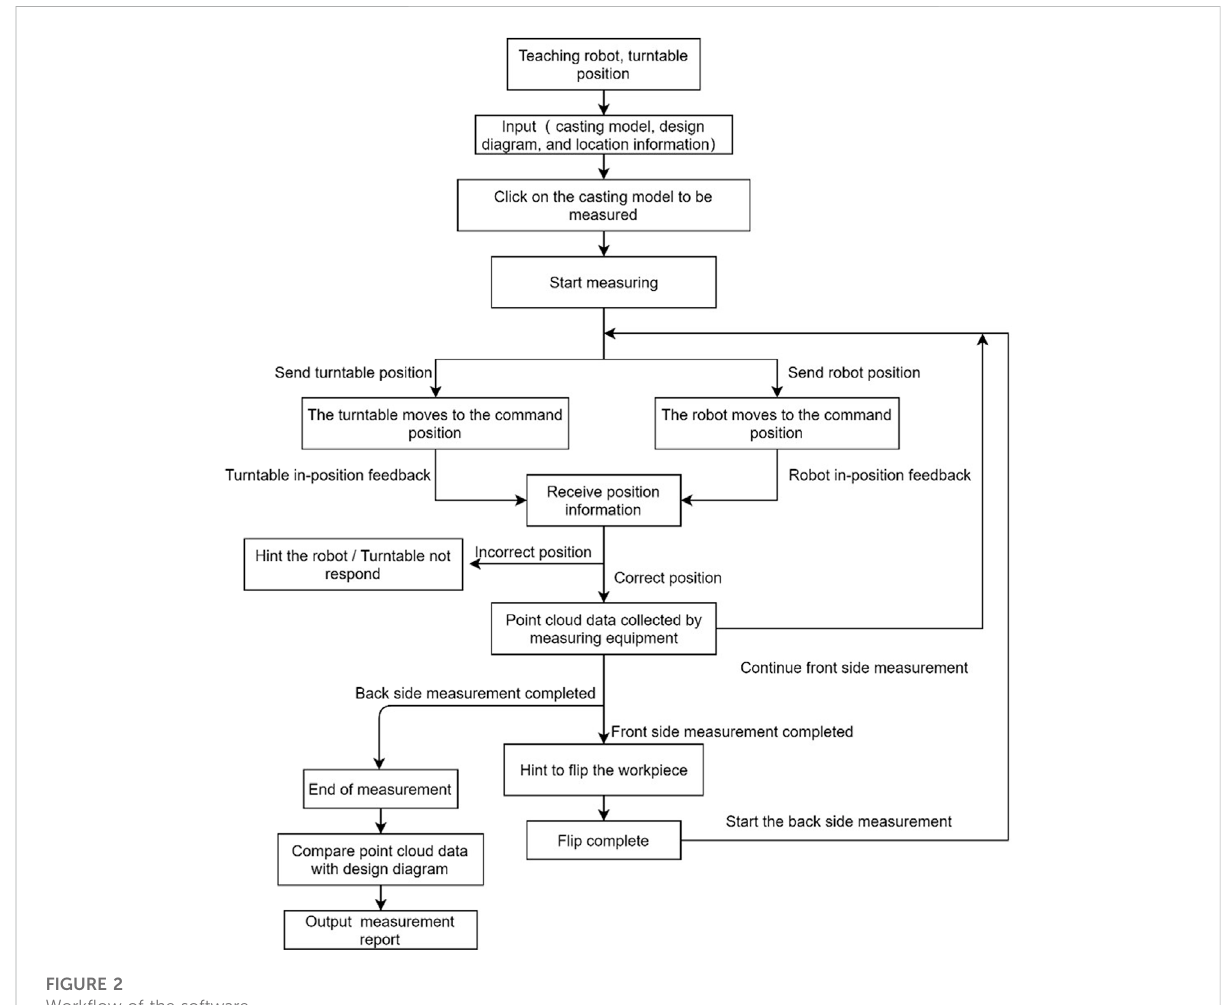
FIGURE 2 Work fl ow of the software.